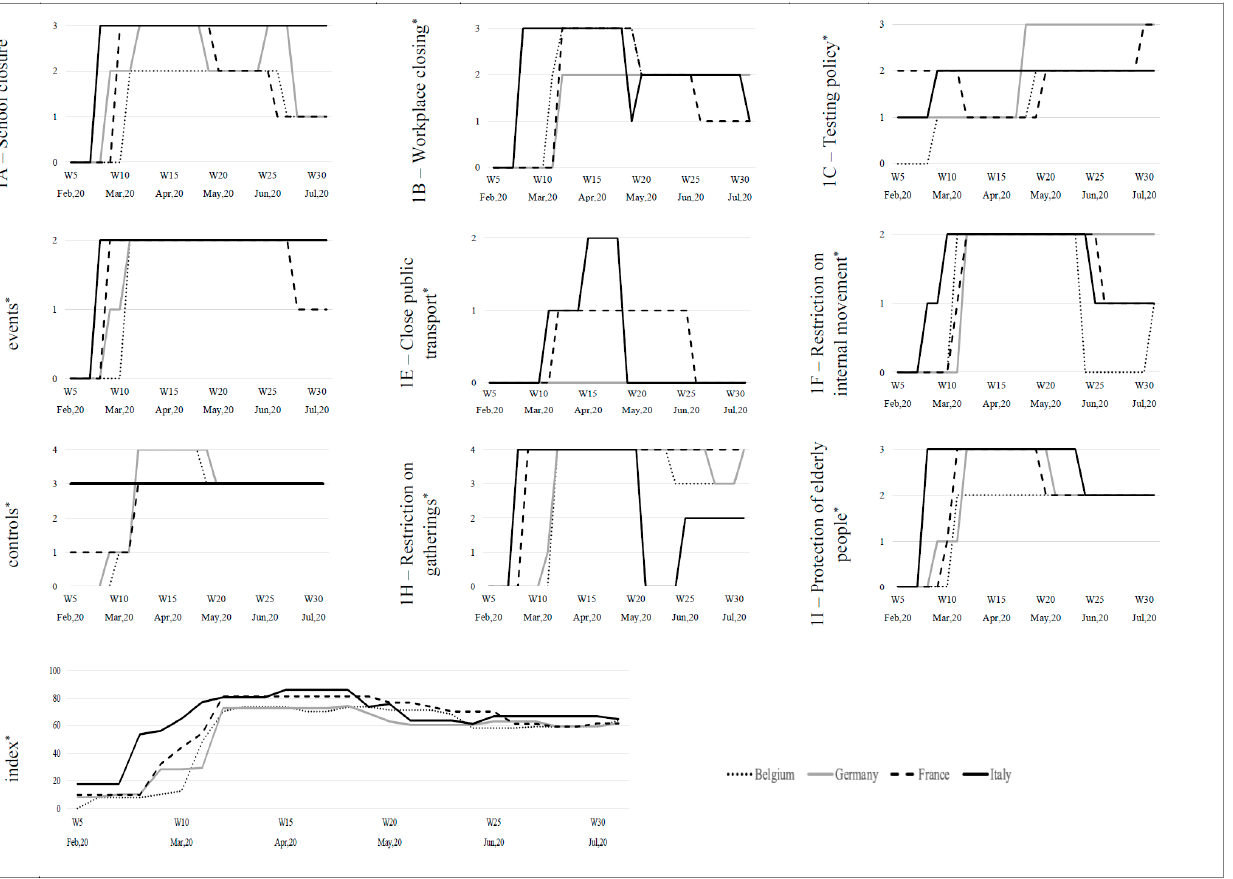
Figure 1. Containment and closure policies indicators and “Modified stringency index” in Belgium, France, Germany, Italy: trends between 1 February and 31 July 2020. * School closure : (0)